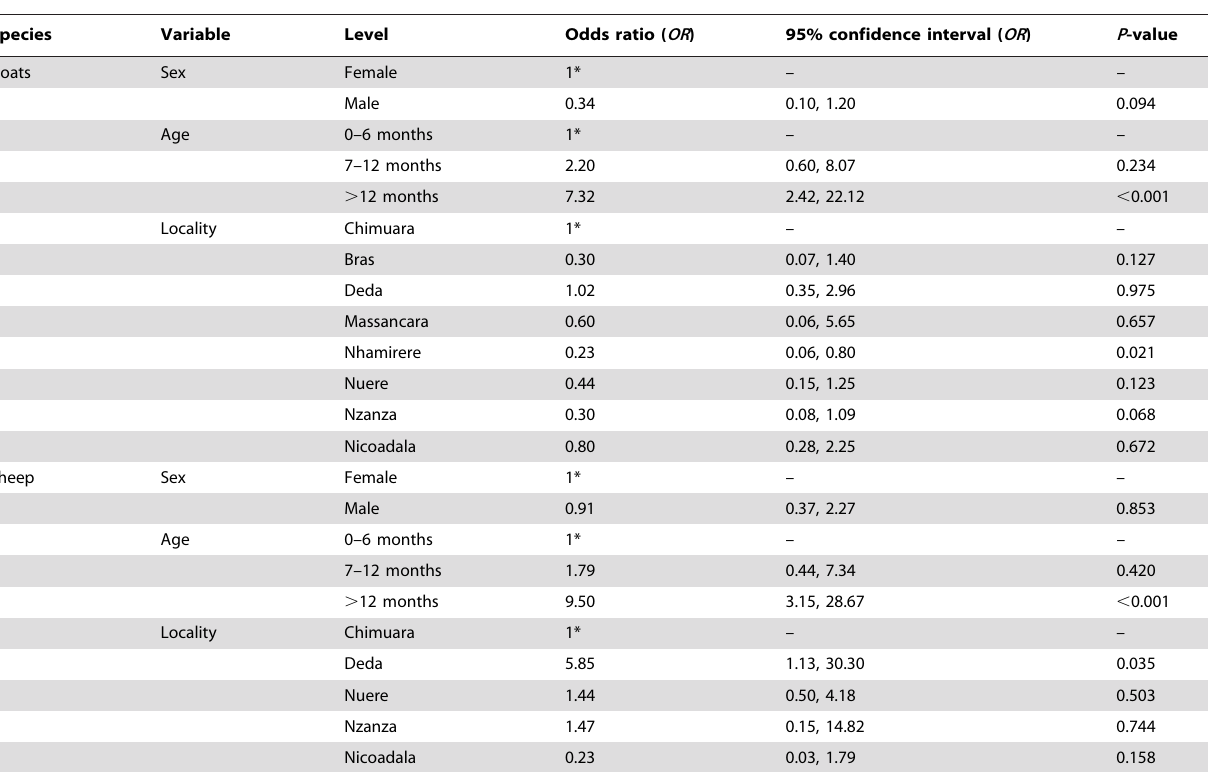
Table 4 shows the effect of sex, age and locality on seropositivity to RVFV in sheep and goats in Mopeia and Nicoadala districts, Zambe´zia, in 2010 as determined by multiple logistic regression models.